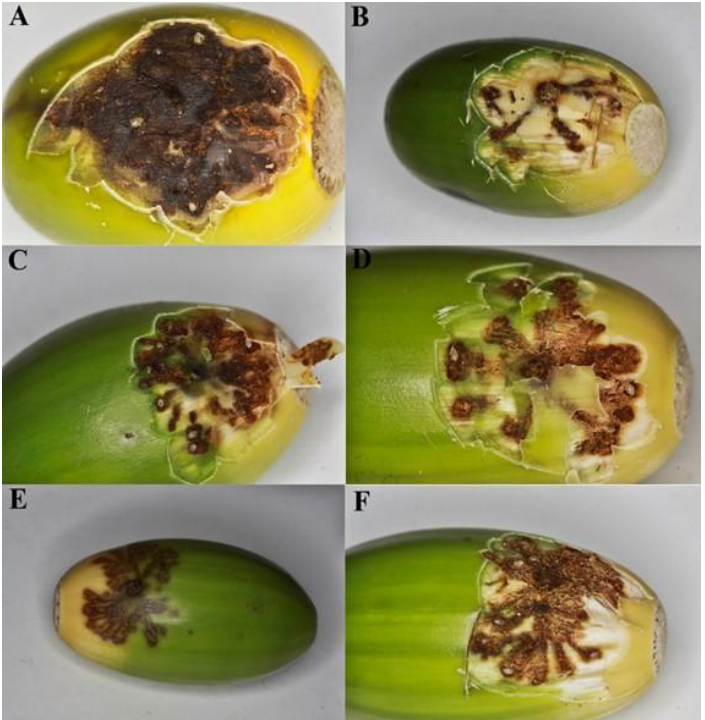
Figure 5. Egg galleries created by C. glandium females: ( A – D ) eggs placed at the end of the channels; all channels start from the same point, resembling a star in shape; many empty channels can be seen, ( E , F ) the same acorn before and after surface